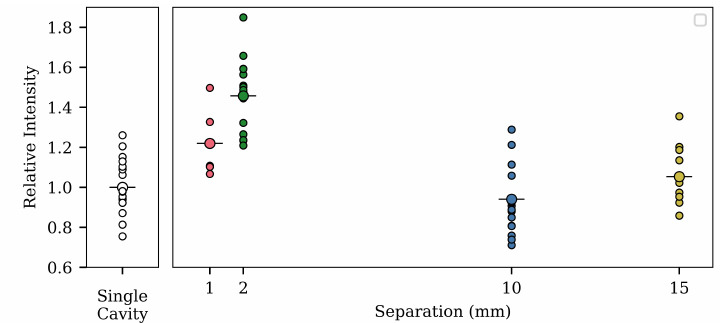
Figure 7. Photoluminescence intensity from dual cavities. The intensities are shown relative to the average intensity for a reference batch of single-cavity fibers (left-most plot) with 0.15mm cavity lengths. In the graph on the right side, the relative peak intensity is shown for all the different fibers. The larger circle with the horizontal line through is the average for the batch, while the smaller circles are the individual fiber responses. The cavities had average depths of 125µm and average lengths of 130µm. The left most plot shows the variation of the single-cavity fibers. Ideally, the reference batch and dual-cavity fibers would have had the same cavity dimensions, but the fabrication method made this difficult. However, the goal is to show the relative impact on dual-cavity separation. The trend shows a maximum existing at 2mm, where after, the addition of a second cavity has less impact.